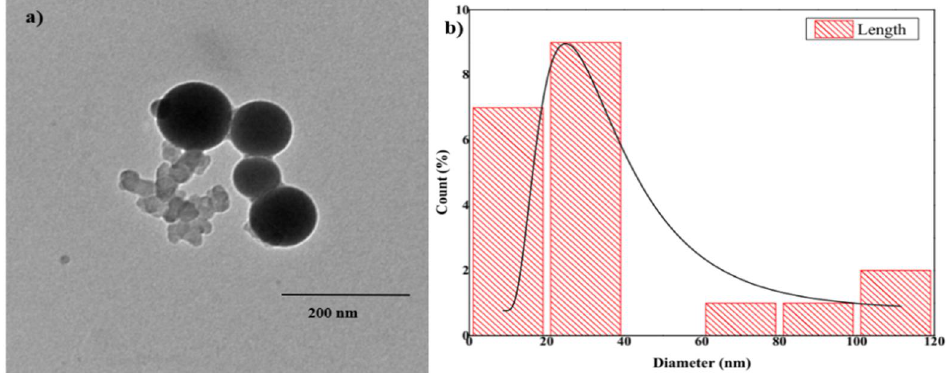
Figure 1. Transmission electron micrographs of zinc oxide nanoparticles showing ( a ) spherical- shaped zinc oxide nanoparticles (ZnONPs), ( b ) size distribution curve.